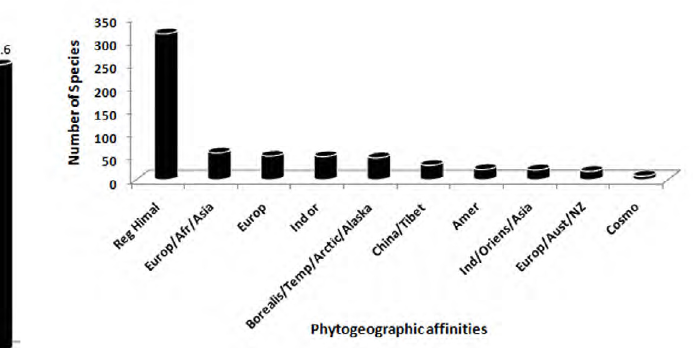
Figure 4. Abbreviations used Number of species in different phytogeographic realms. : Afr=Africa; Amer=America; Austr=Australia; Bor=Boreal (North Temperate Zone); Centr=Central; Cosmo= Cosmopolitan; Europ=Europe; Himal=Himalayan; Ind=India; Min=Minor; Mongol=Mongolia; NZ= New Zealand; Oriens=Oriental, Reg=Region;